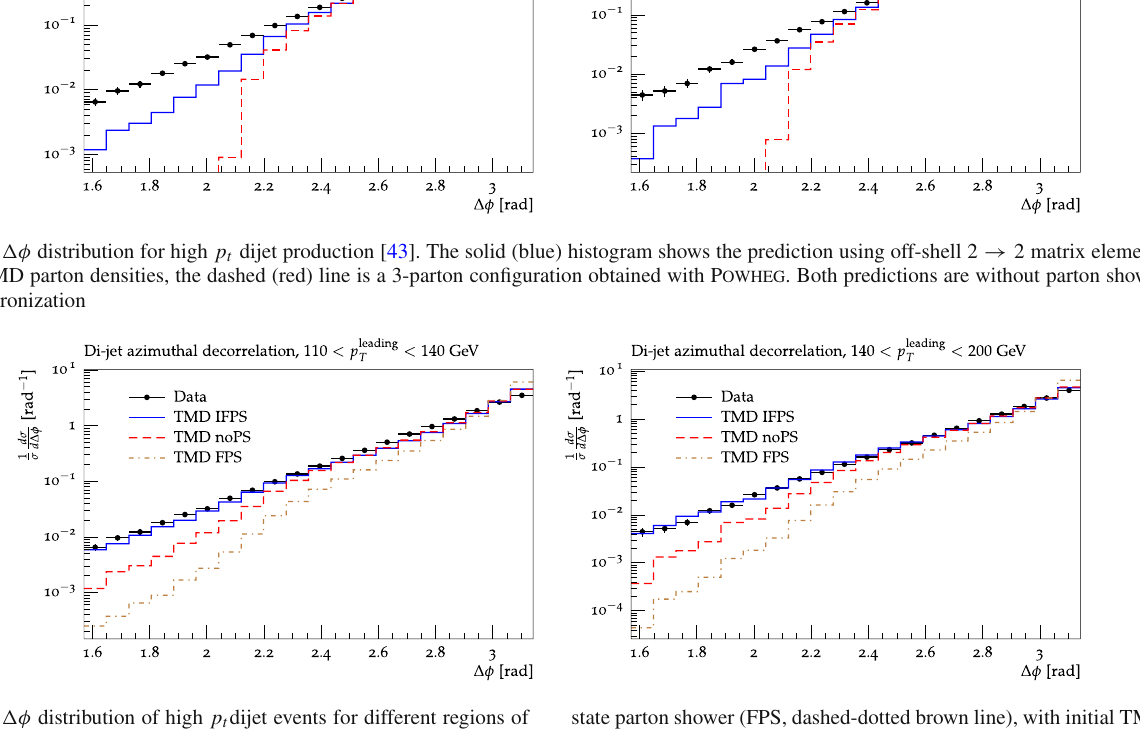
state parton shower (FPS, dashed-dotted brown line), with initial TMD shower and final state parton shower (IFPS, blue solid line). The fac- torization scale μ 2 = Q 2 t + ˆ s was